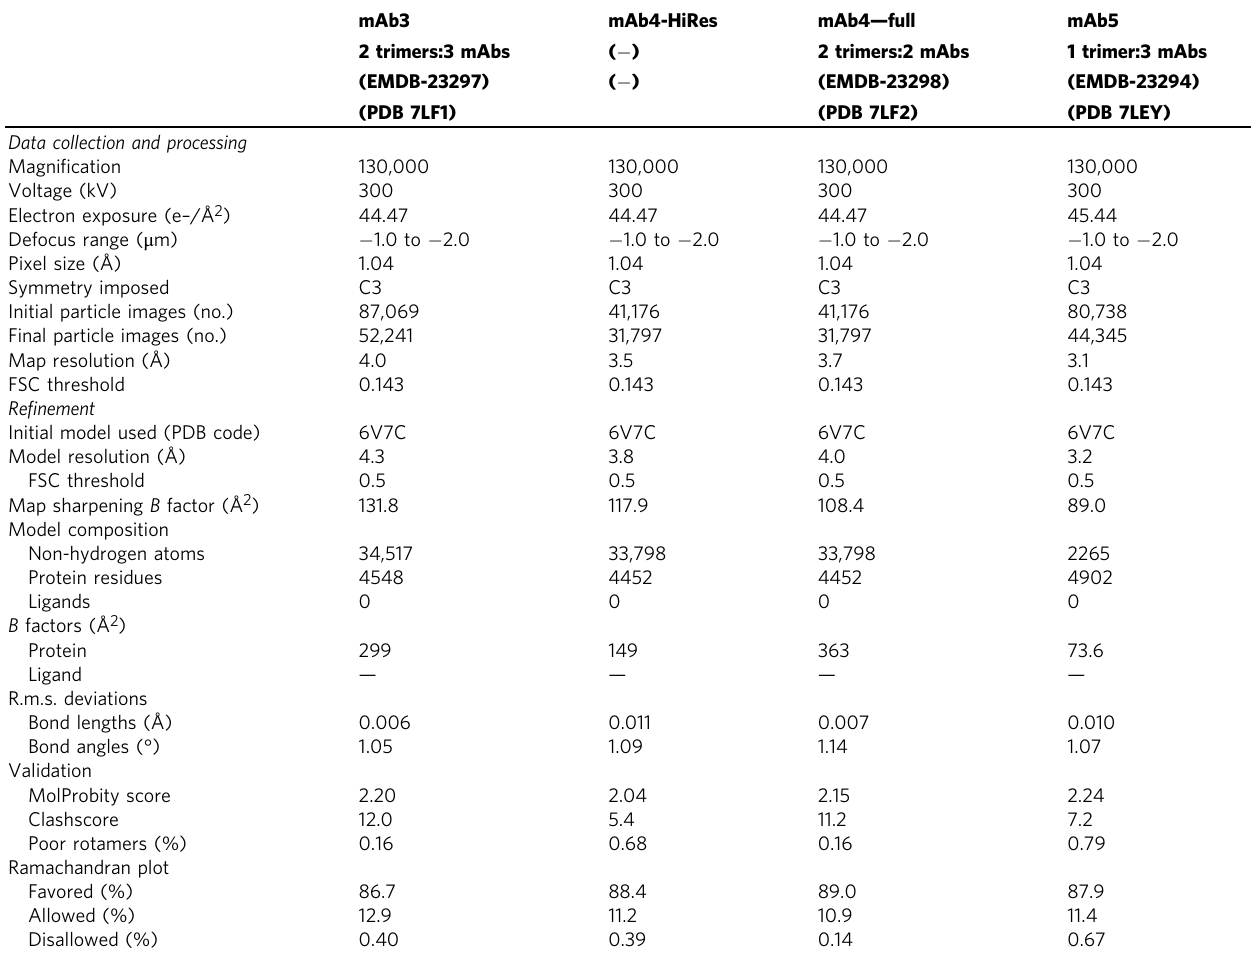
Table 2 Cryo-EM data collection, re fi nement and validation statistics for mAb3, mAb4 and mAb5